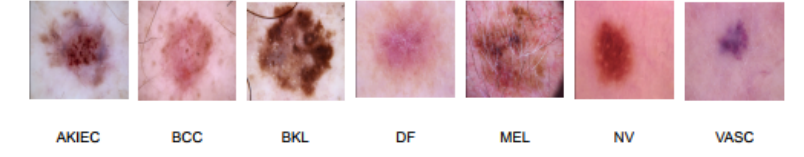
Figure 1. Example image of each class.